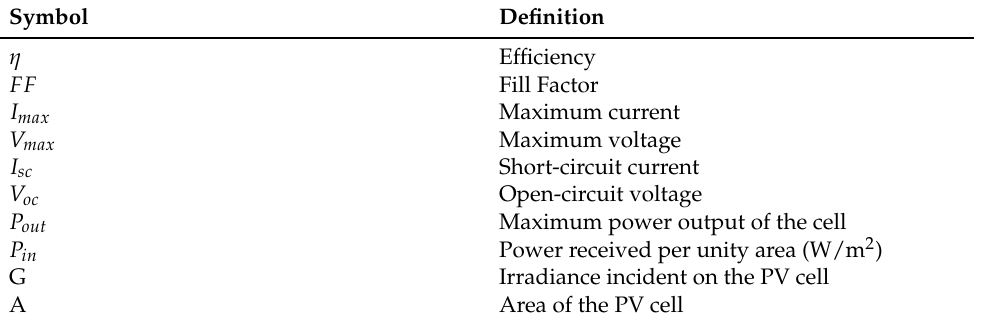
Table 1. Definitions of the symbols used in Equations (1) and (2).